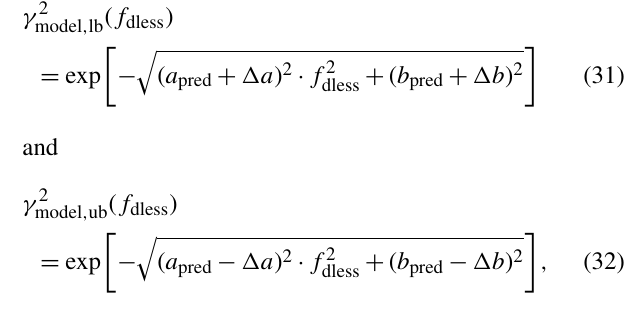
Fig. 12. The lower and upper bounds of the RMSE interval are determined